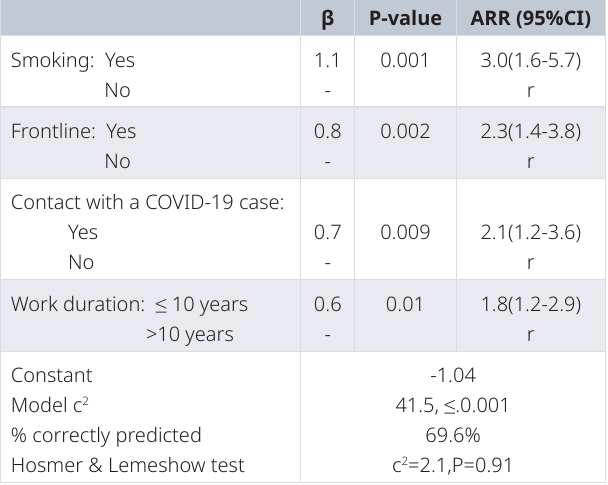
Table 3. Logistic regression analysis of independent predictors of self-reported COVID-19